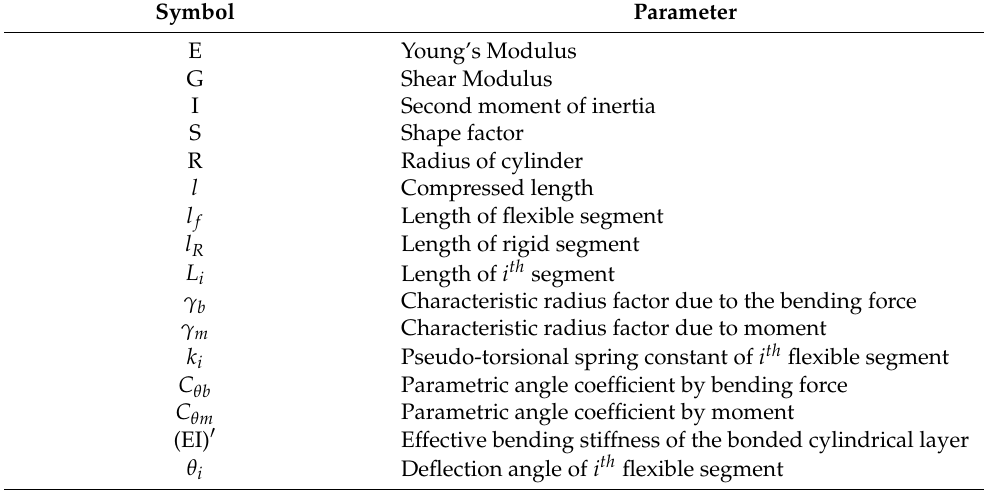
Table 2. Nomenclature of parameters used in numerical